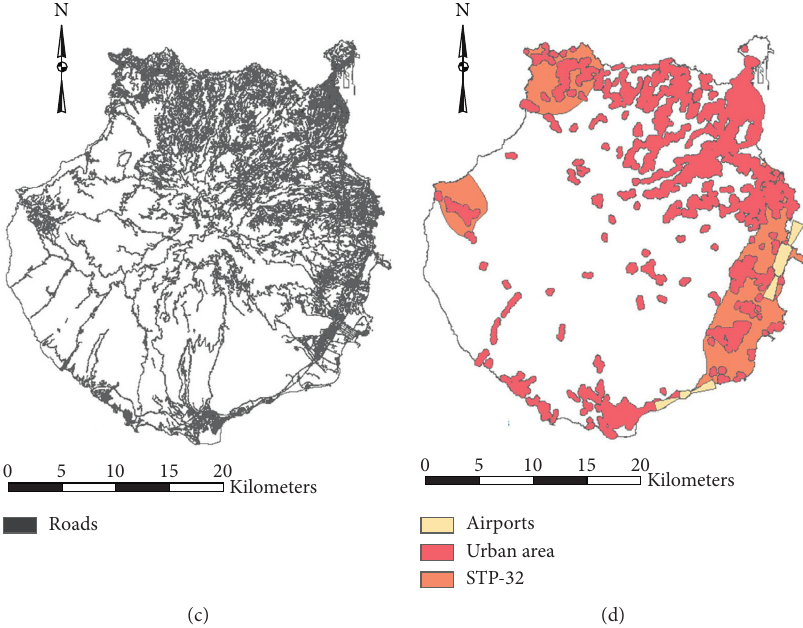
Figure 8: Constraints: (a) protected areas, (b) military areas, sea-land limits (100m), and water bodies, (c) roads (20 m), and (d) airports, urban area (250 m), and special territorial